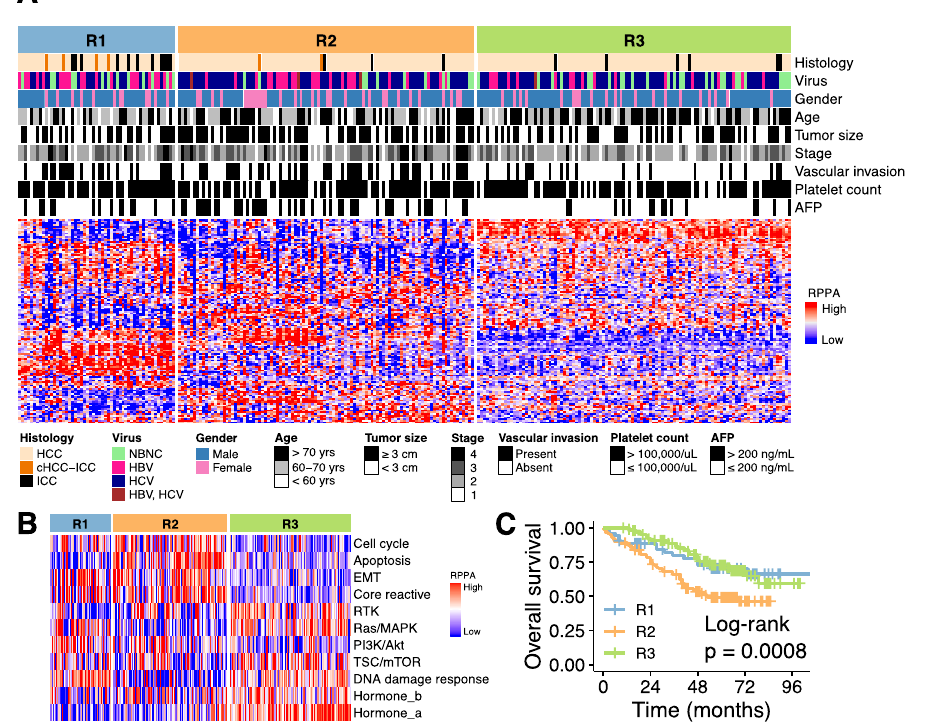
Fig. 3 | Proteomic subclasses of primary liver cancers. A Proteomic subclasses R1 – R3, clinical features, and protein expression levels in 259 tumors. Heatmap shows expression levels of 122 proteins that were used for consensus clustering of the tumors. HCC hepatocellular carcinoma, ICC intrahepatic cholangiocarcinoma, cHCC-ICC combined HCC-ICC, NBNC non-hepatitis B non-hepatitis C. B Pathway